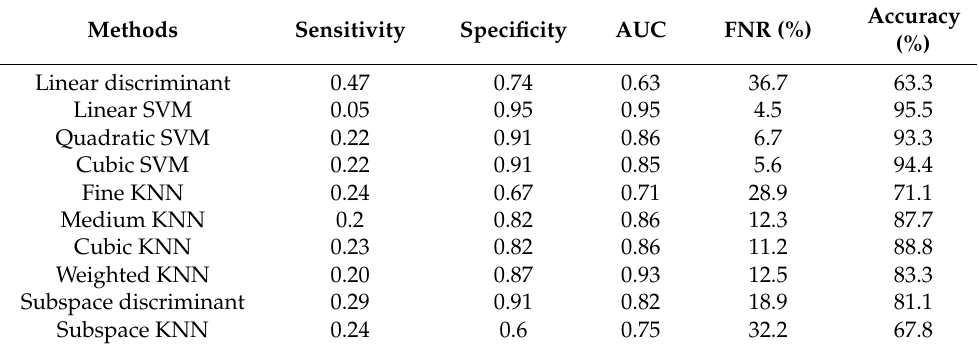
Table 4. Sooty mold vs. healthy mango leaves.